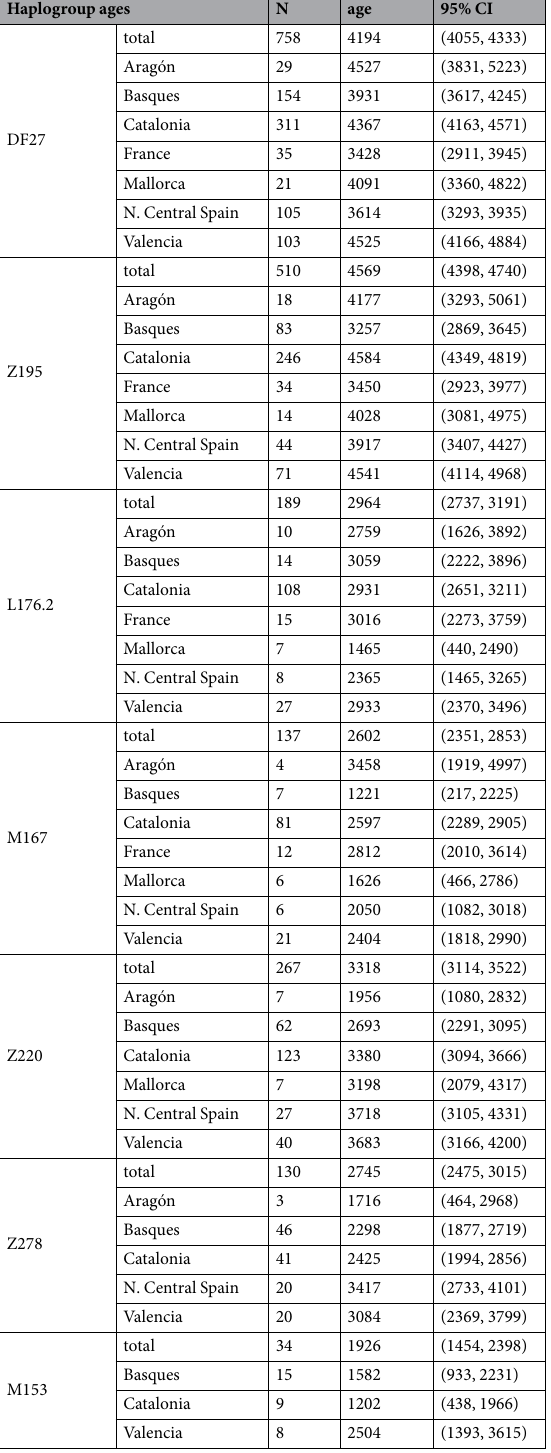
Table 3. Haplogroup ages estimated from STR variation with the weighted ρ method. 95% CI: 95% confidence